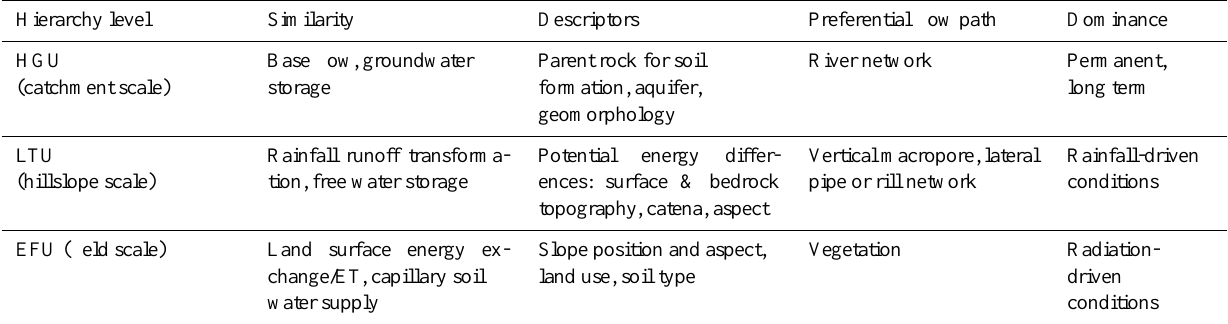
Table 2. Hierarchy of proposed functional classification scheme, controlled form of water release, candidate descriptors, dominant preferen- tial flow path, and hydrological context of